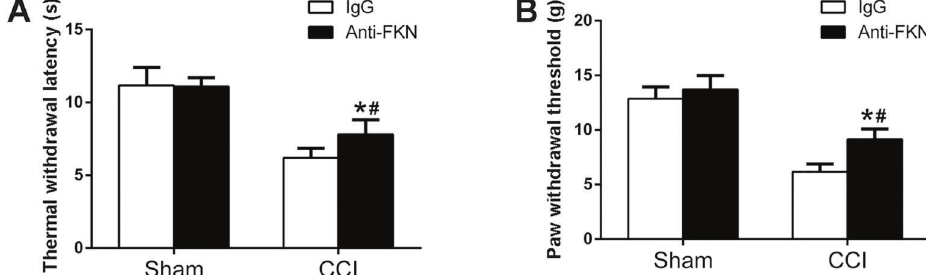
Figure 5. Fractalkine (FKN)-neutralizing antibody prevented chronic constriction injury (CCI)-induced pain. A , Thermal hyperalgesia after administration (F=58.575). B , Paw withdrawal threshold (F=92.935). *P o 0.05 vs CCI + IgG group, # P o 0.05 vs Sham + Anti-FKN group, n=8 per group (two-way ANOVA, LSD